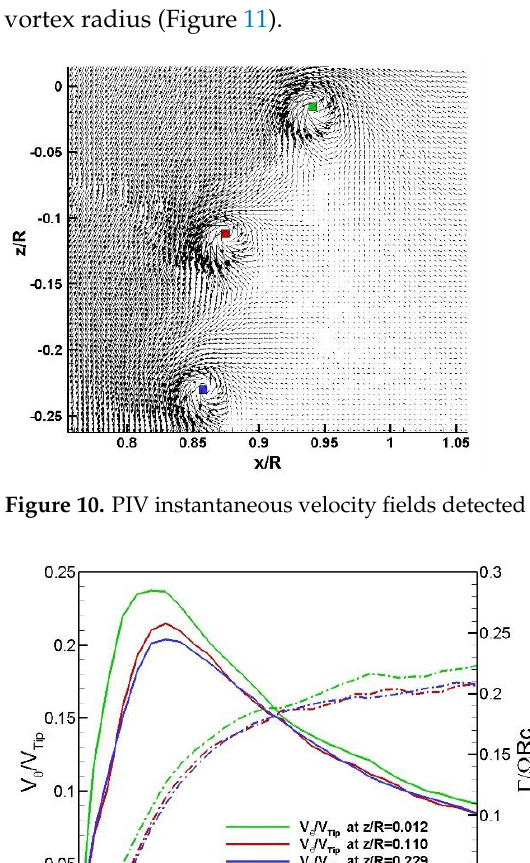
Figure 12. BEM (blue) and Experimental (red) normalised core radius versus the distance from the rotor disk. The distribution of the experimental vortex centres, Figure 13, showed the highest concentration in the proximity to the rotor disk and that their location was enclosed in the shear layer region. Moving downstream, the data scattering increased distributing the centres of the vortical structures both outside and inside the ensemble-averaged down- wash, whereas the concentration of vortex decreased due to the fading and/or merging of vortices. The same representation for the numerical vortex centres showed an extremely narrow region of the shear layer and an almost full match between the boundaries of the shear layer region and the path of the vortex centres. Additional characterization of the instantaneous tip vortices was obtained by evalu- ating the composition of the vorticity orthogonal to the PIV plane ω = (∇ × V) ⊥ and com- paring the experimental results with the numerical simulations. Figure 14 illustrates the results of this comparison. A cut-off of the vorticity module was set at 1500 1 s⁄ to remove as much as possible the flow field small-scale turbulence and to have a more concentrated